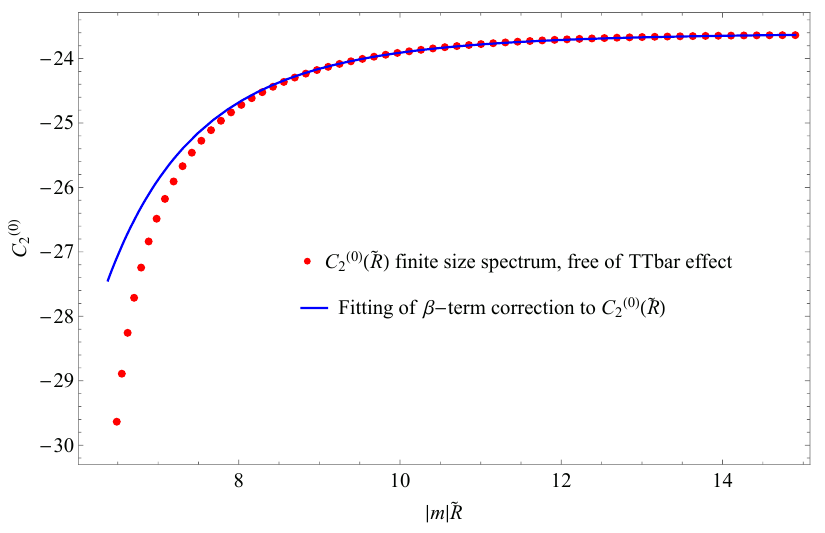
( ˜ R ) with the power law ˜ R − 28 5 . Note that now the 2